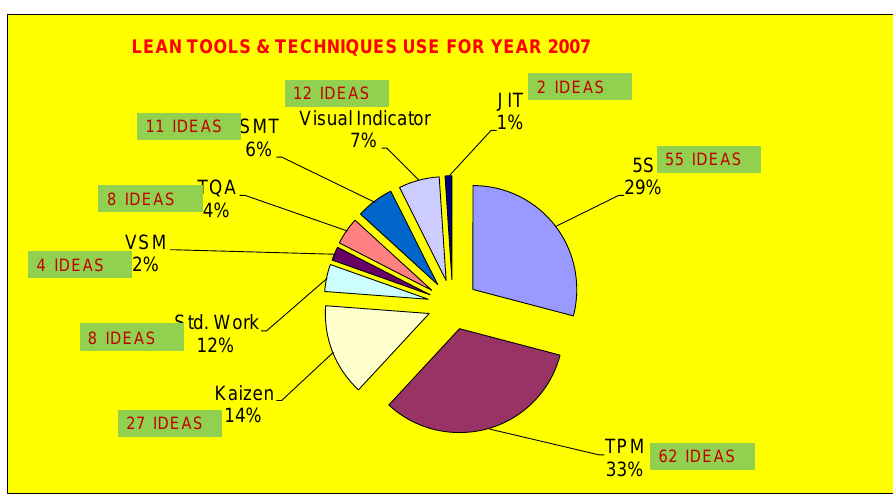
Figure 23. “Lean Tools used in problem